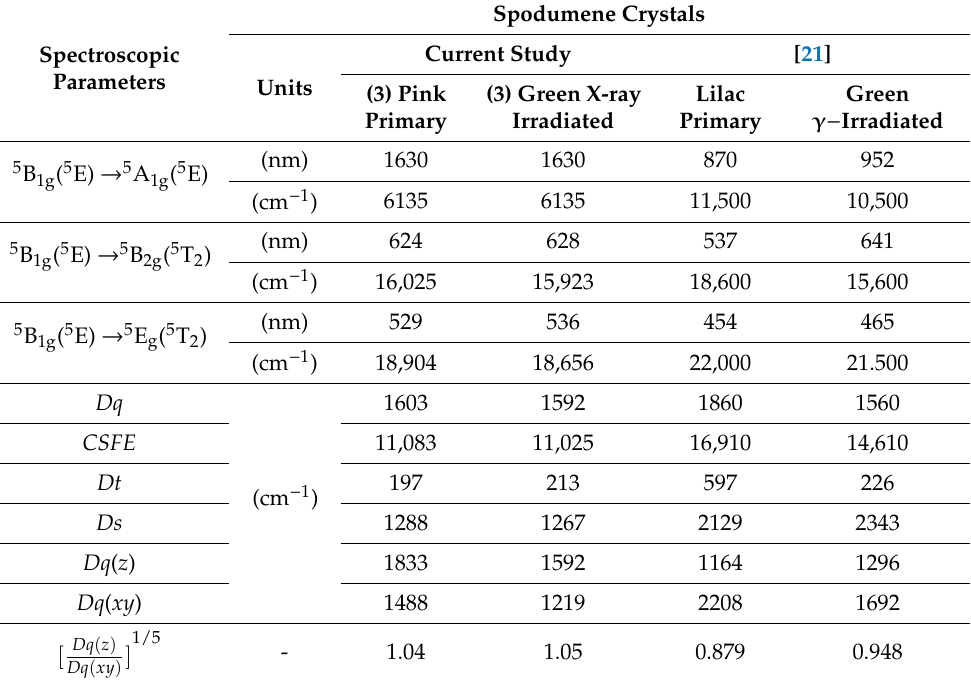
Table 3. Spectroscopic parameters of Mn 3 + in tetragonal site